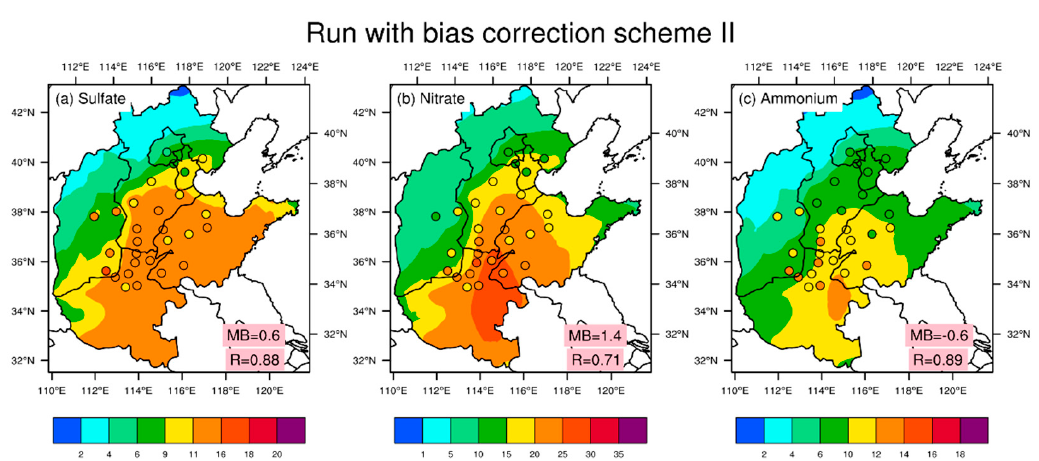
Figure 5. Same as Figure 2 but the results are simulated under bias correction scheme.